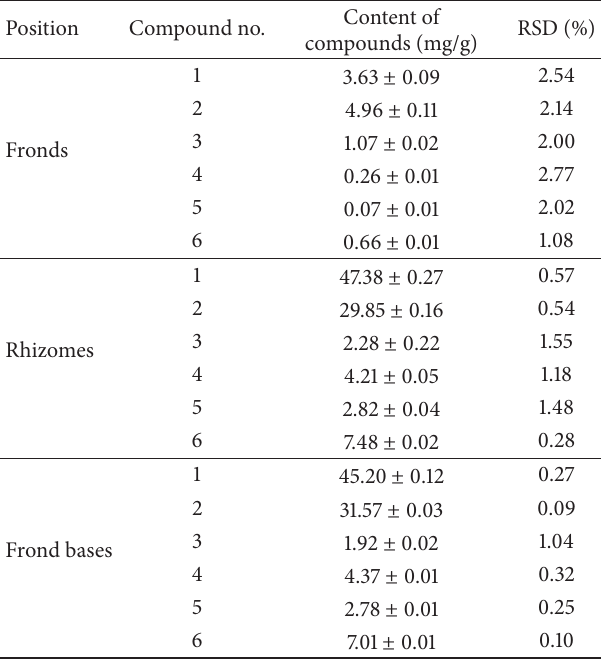
Table 4: Content of the compounds ( 𝑛 = 3 ). Position Compound no.